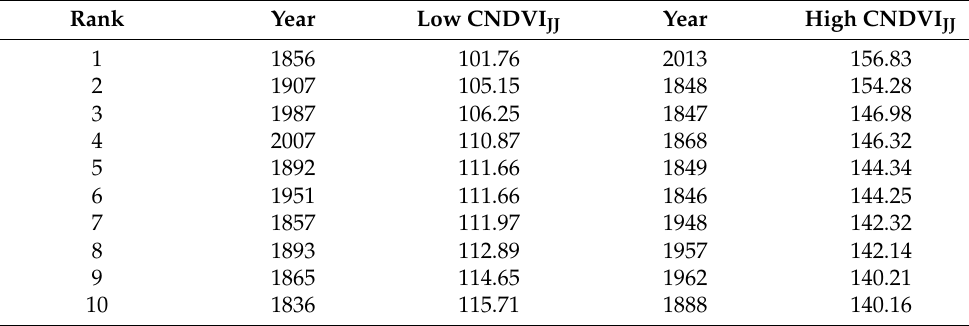
Table 5. Top ten high and low CNDVI JJ years from the 189 y reconstruction.